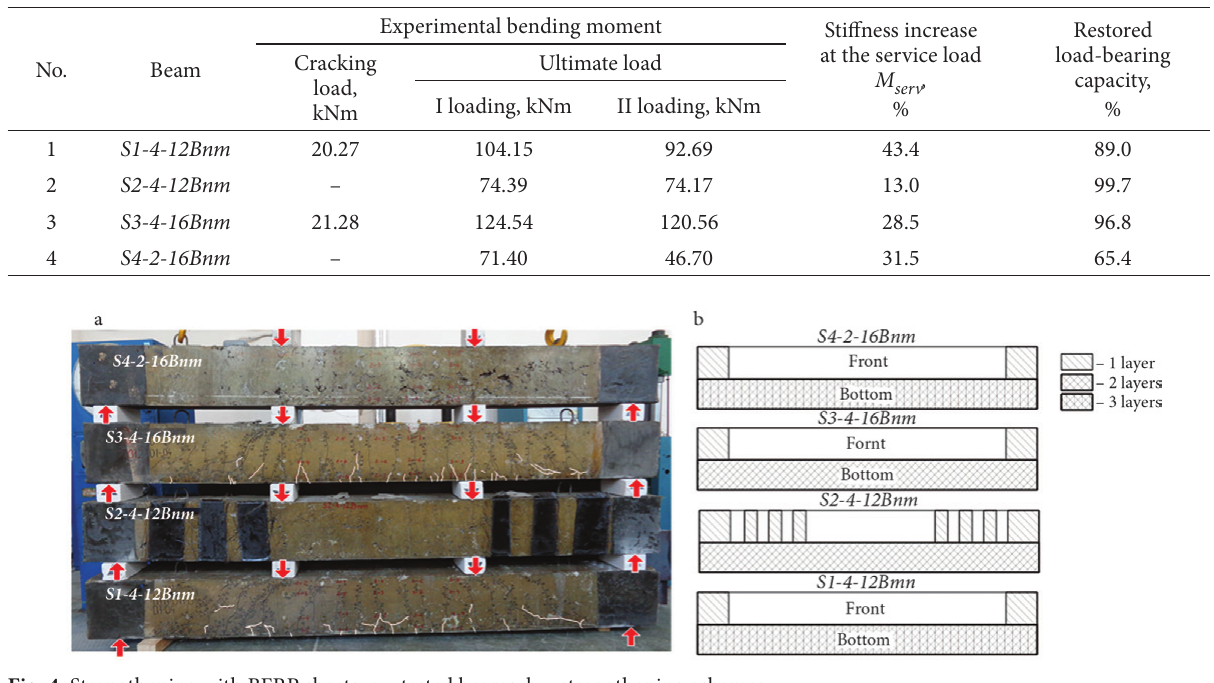
Fig. 4. Strengthening with BFRP sheets: a – tested beams; b – strengthening schemes